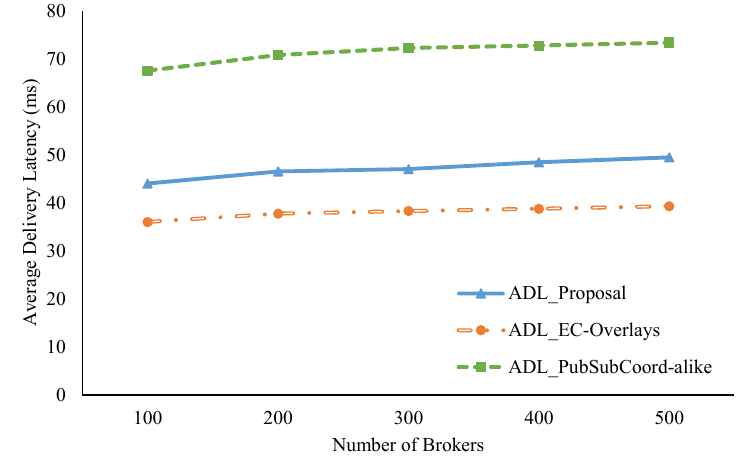
Figure 9. ADL comparison with increasing numbers of